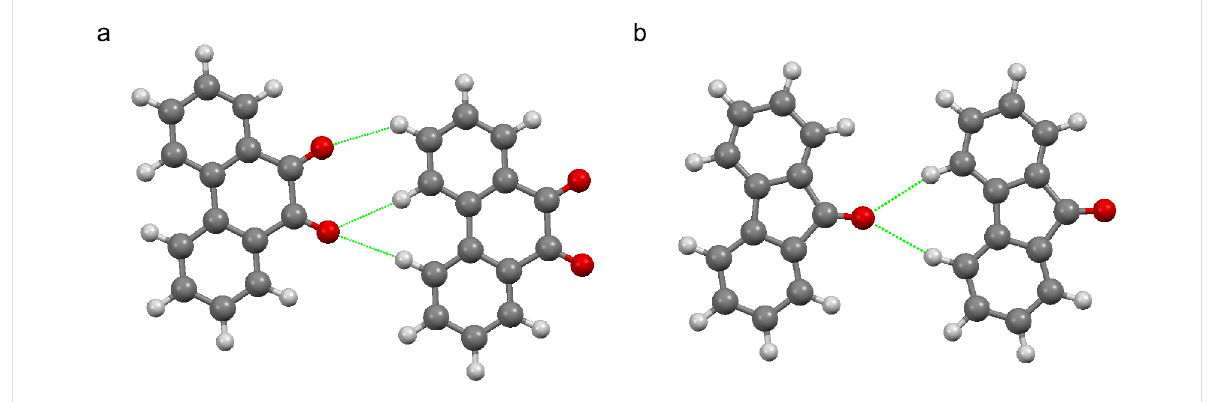
Figure 6: The calculated structure of pairwise interactions in linear rows for (a) 9,10-phenanthrenequinone and (b) 9-fluorenone with the C-H···O hydrogen-bond contacts indicated in green.